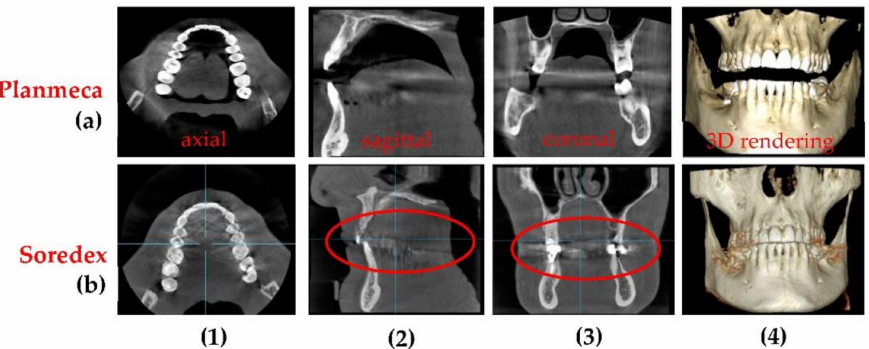
Figure 16. 3D CBCT performed on the same patient (C.C, male, 48 years old) with ( a ) the Planmeca unit and with ( b ) the Soredex unit. Notations: ( 1 ) axial, ( 2 ) sagittal, ( 3 ) coronal, and ( 4 ) 3D